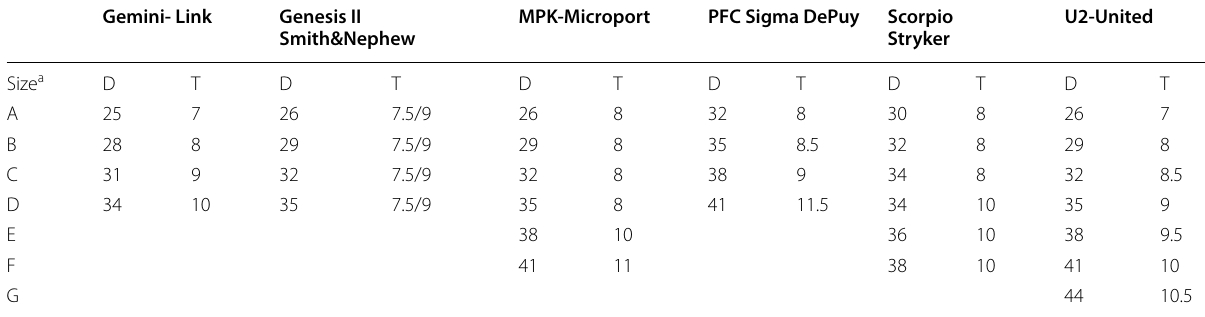
a No uniform sizing categories exist among